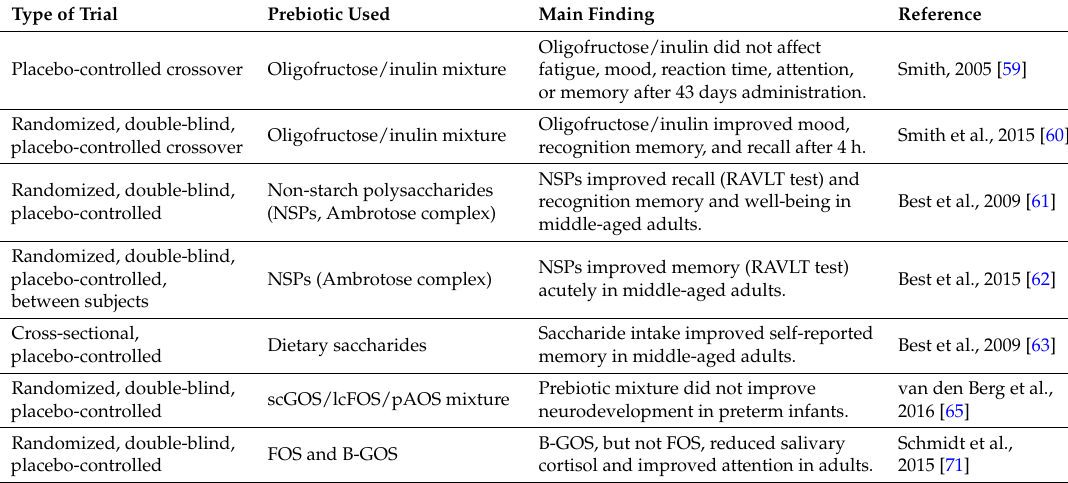
Table 2. Summary of findings from human prebiotic interventions on memory, attention, learning, and